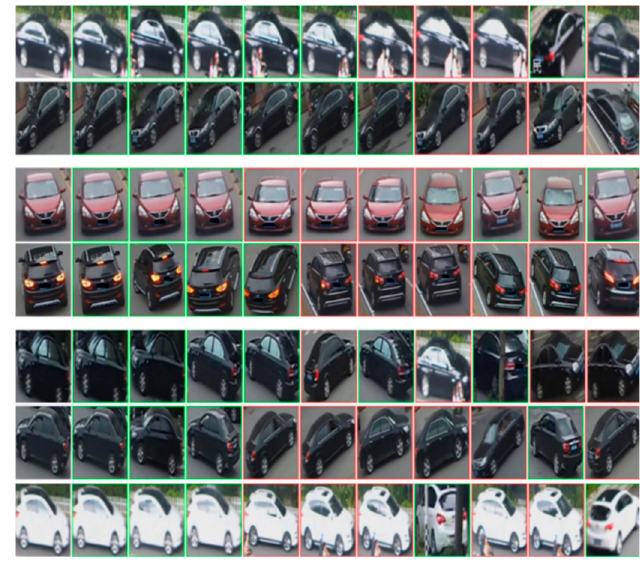
Figure 10. Visualization results for the ranking list of VeRi-776.